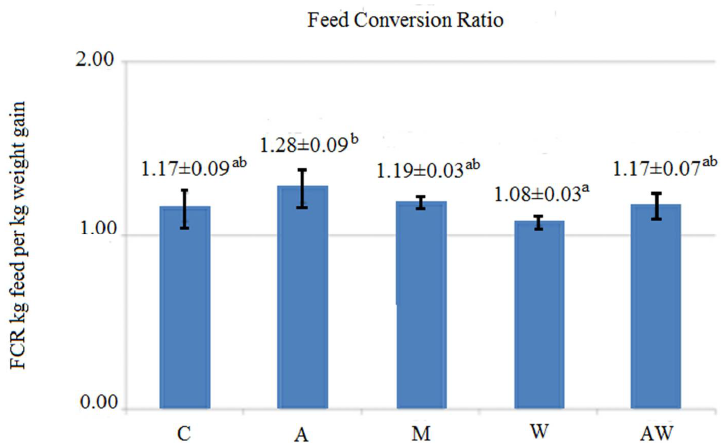
Figure 2. Feed conversion ratio (FCR) of rainbow trout fed the five experimental diets (C, control diet; A, Delesseria sanguinea combined diet; M, Mytilus spp. combined diet; W, Alitta virens combined diet; AW, Alitta virens + Delesseria sanguinea combined diet. Average values and SD are reported. Superscitps with different letters indicate statistical significance, p < 0.05. Significantly, the FCR differed when king ragworm or red algae were combined in the diet, with the former showing the most favorable FCR. The combination of ragworms (35%) in the diet of rainbow trout produced the lowest FCR when compared to the other experimental diets, in a non-significant way, except for the A diet ( p < 0.05). 4. Discussion This investigation assessed, for the first time, the nutrient composition and potential combination of local marine coastal organisms in the diet of rainbow trout. Sufficient protein content and composition in commercially farmed ragworms Alitta virens , also sufficient phosphorous content of 7.82 g×kg -1 DM (6 g×kg-1 DM minimum recommended [15]), displayed to possess the highest potential for fishmeal supplementation; red algae, Delesseria sanguinea , which is relatively rich in protein, but also has a high N-free extract (NfE) fraction, mostly contained floridean starch [16], a typical energy storage molecule of red algae species, which may lead to digestive disorders; whole blue mussel, Mytilus spp., displayed an adequate protein composition, but low concentration, as well as high crude ash fraction due to the shell. Additionally, the CaCO 3 of the shell might also be a problem due to the potential compromising effects of acidic milieu in the stomach. Nevertheless, the blue mussel, Mytilus edulis, was found to be utilizable in trout feeds previously [17], but the performance is supposed to decline rapidly when trout are fed over 45% of the diet. HCl insoluble ash, which can be interpreted as the sand fraction, was less than 4% in all the samples. Appreciable crude fat values were only found in the ragworm (7.62%). The NfE fraction was the highest in the red algae (43.7%), relatively low in the ragworms (9.18%) and the lowest in the mussel (1.3%). As mentioned before, the shell represents a large fraction of mussel meal, and this is the reason why noticeable amounts of Ca could be found in it (299 g×kg −1 ); the ragworm meal showed the highest P content (7.82 g×kg −1 ). The other organisms had p values less than 1/3 of the ragworm content. Noteworthy, manganese is the highest trace element found in the red algae meal (2.91 g×kg −1 ). The amino acid composition of the tested organisms, as an alternative source of protein, did